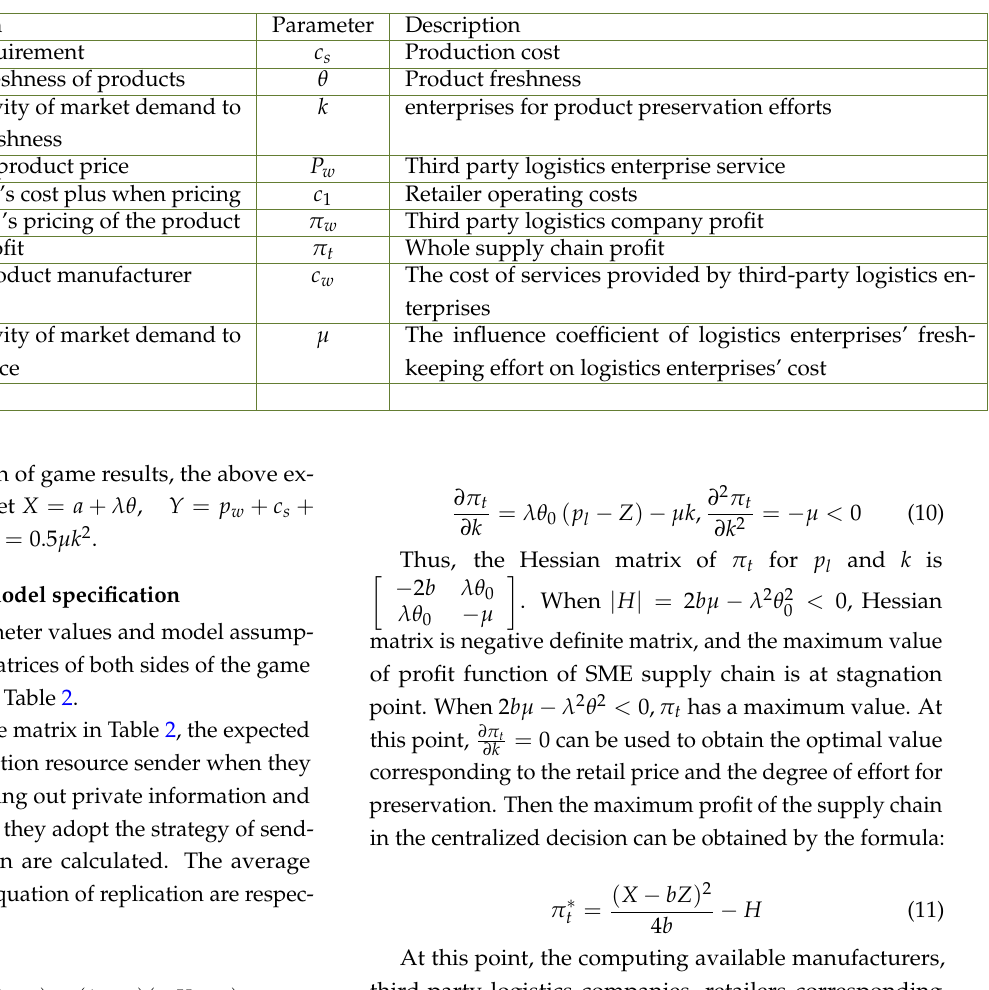
Table 1. Parameter